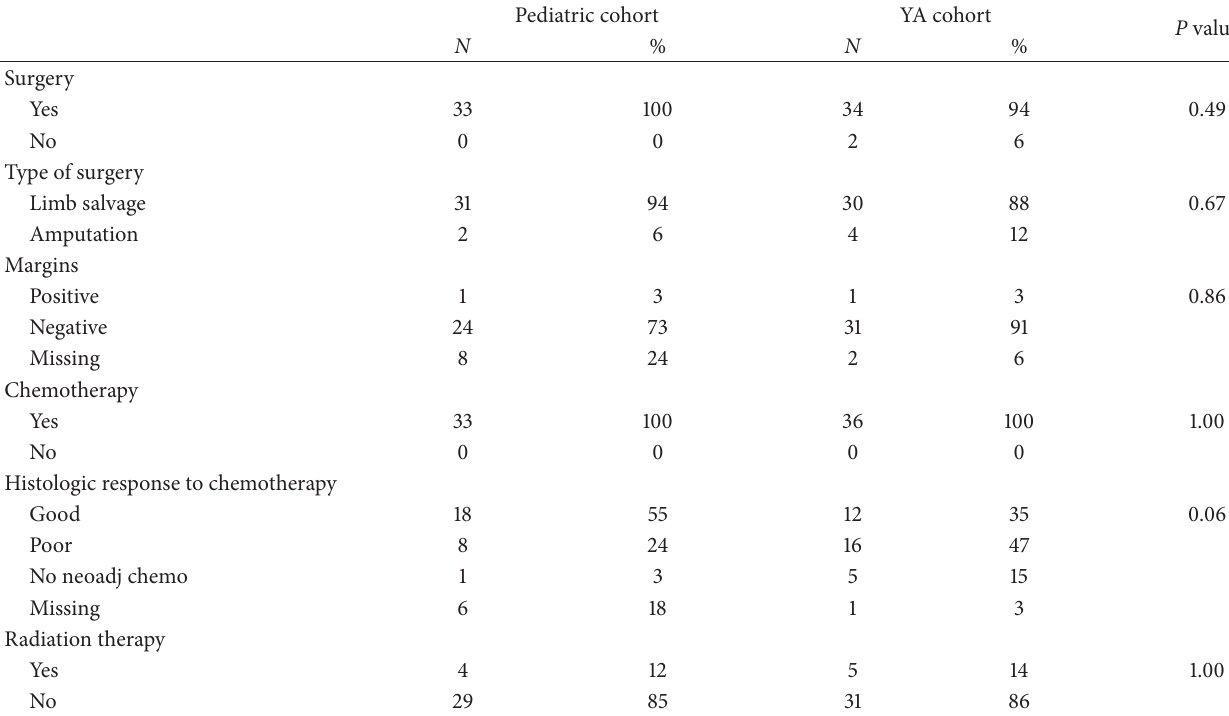
Figure 2: The YA cohort received less chemotherapy than the typical pediatric regimen. (a) Heat map for the YA cohort’s chemotherapy regimen, with each column representing 1 patient. The green squares indicate that the patient received the typical dose according to pediatric osteosarcoma protocols. The red squares indicate that the patient received fewer doses than the typical pediatric dose. Asterisks ( ∗ ) indicate patients who progressed on primary therapy. Light green box indicates patient who received etoposide/ifosfamide instead of cisplatin. (b) Percentage of patients in the YA cohort that received each dose of chemotherapy. The black bars indicate the typical dose of each drug for pediatric patients. The percentages shown indicate the percentage of patients in the YA cohort that received less than the typical dose. Table 2: Therapeutic modalities